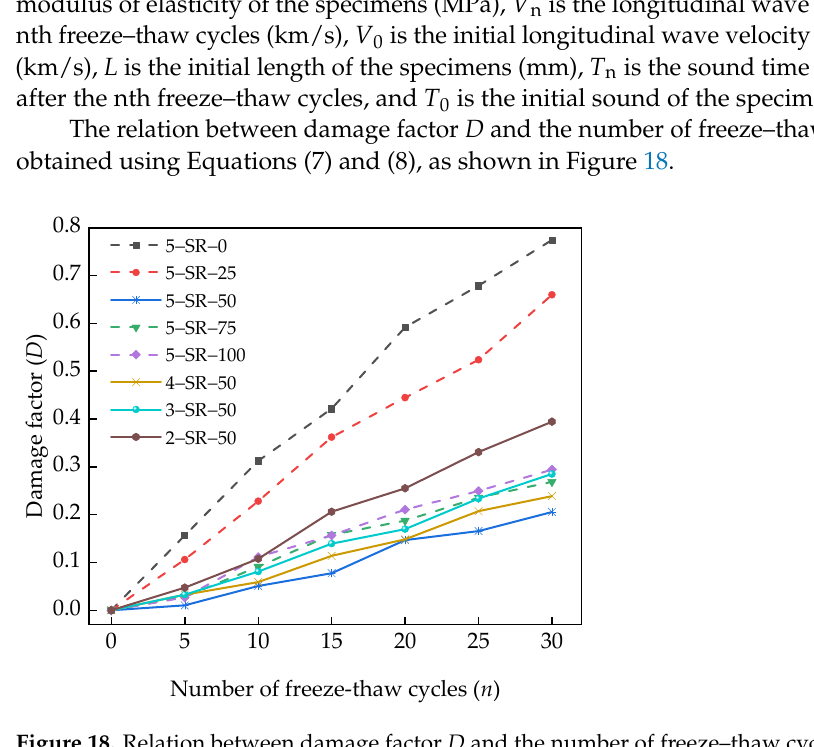
Figure 18. Relation between damage factor D and the number of freeze–thaw cycles n.